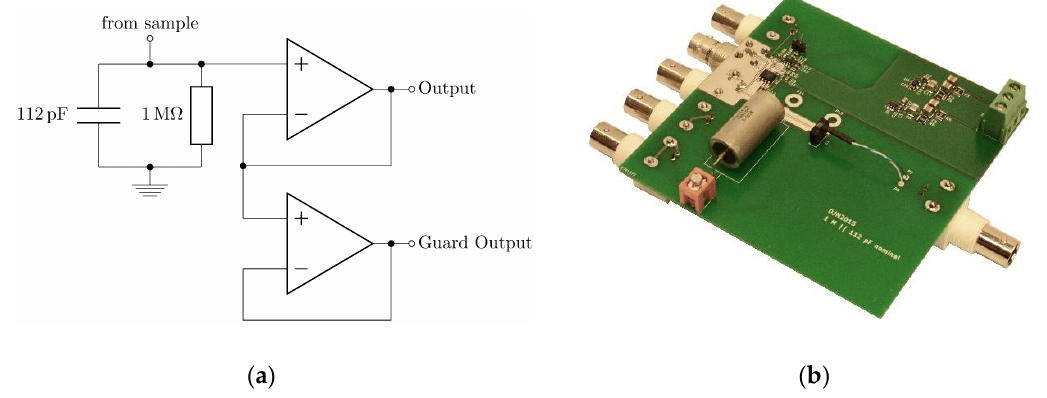
Figure 5. ( a ) A simplified schematic of the reference impedance; ( b ) the actual